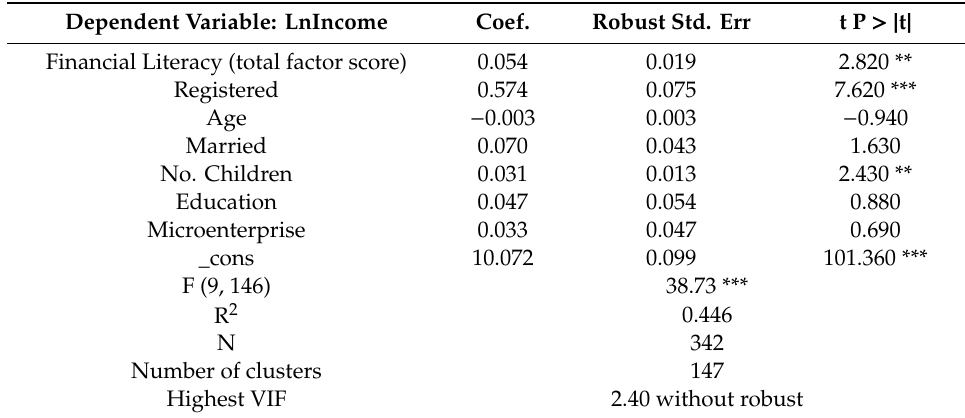
Table 7. OLS regression with dependent variable financial status (Hypothesis 2 and Hypothesis 3) (N = 342).